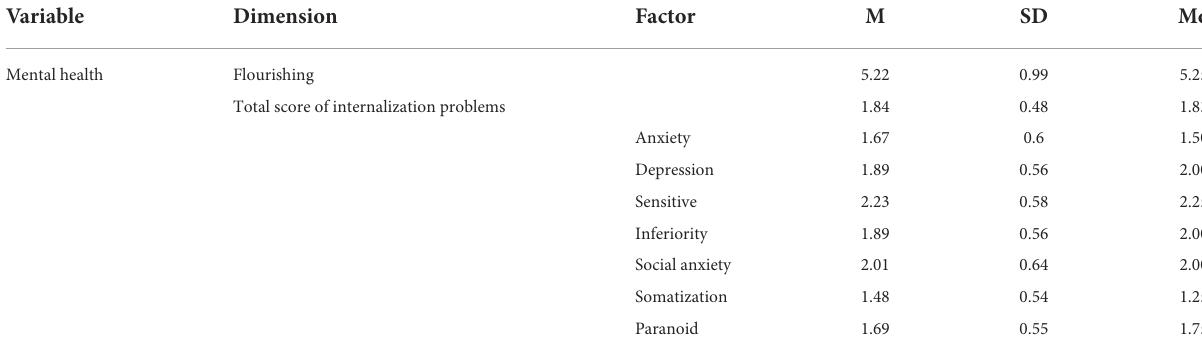
TABLE 2 Overall mental health of the postgraduates.